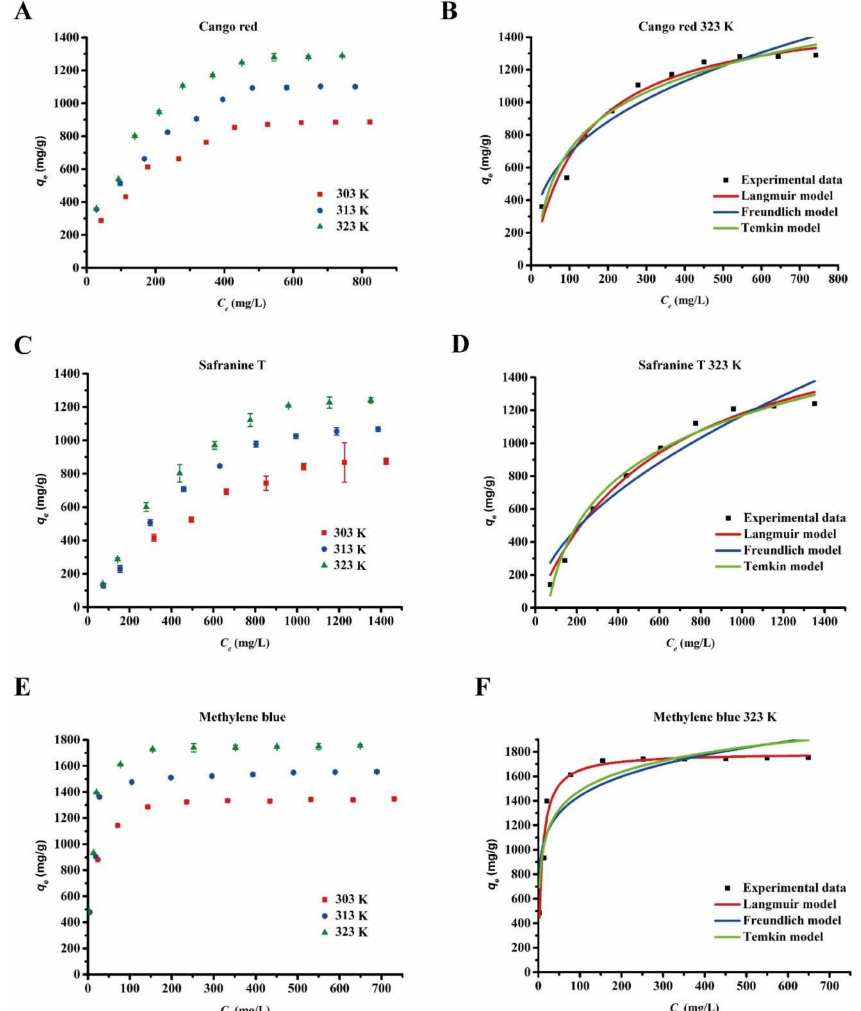
Figure 6. Equilibrium isotherms of the dyes after adsorption by Bio-SeNPs. Various concentrations of congo red ( A ); safranine T ( C ) and methylene blue ( E ) were removed by 0.2 g/L Bio-SeNPs at 303, 313 and 323 K, respectively. Data are presented as mean ± SD of three replicates. Langmuir, Freundlich and Temkin models of congo red ( B ); safranine T ( D ) and methylene blue ( F ) adsorption onto Bio-SeNPs were fitted using average values at 323